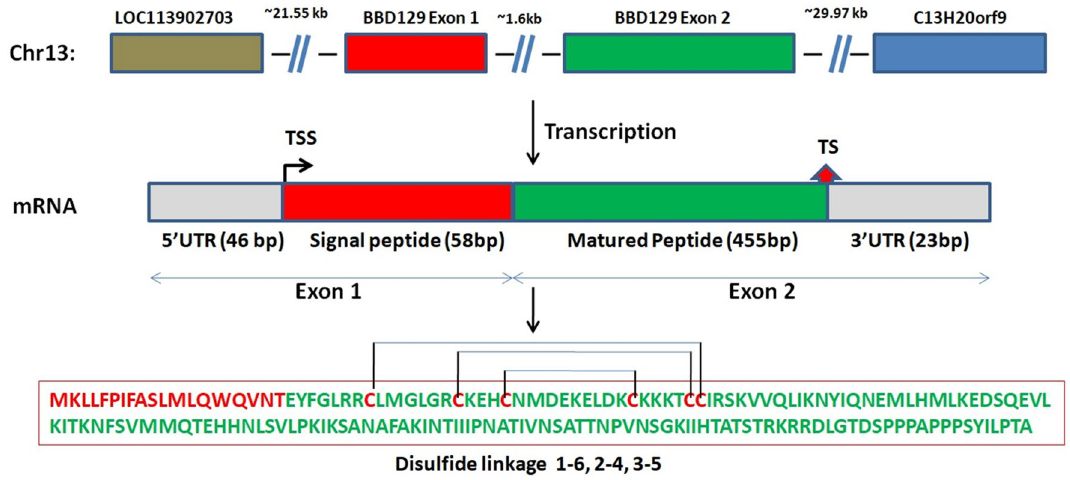
Figure 1. The full-length coding BBD129 mRNA characterization in Bos indicus x Bos taurus . The BBD129 gene is located on chromosome 13, and it encodes for 582 bp long mRNA transcript, giving a 171 amino acids long polypeptide. The DiANNA web server has predicted Cys1-Cys6, Cys2-Cys4 and Cys3-Cys5 disulfide linkages. Abbreviations: Chr = Chromosome, TSS = Transcription start site, TS = Termination site, and UTRs = Untranslated